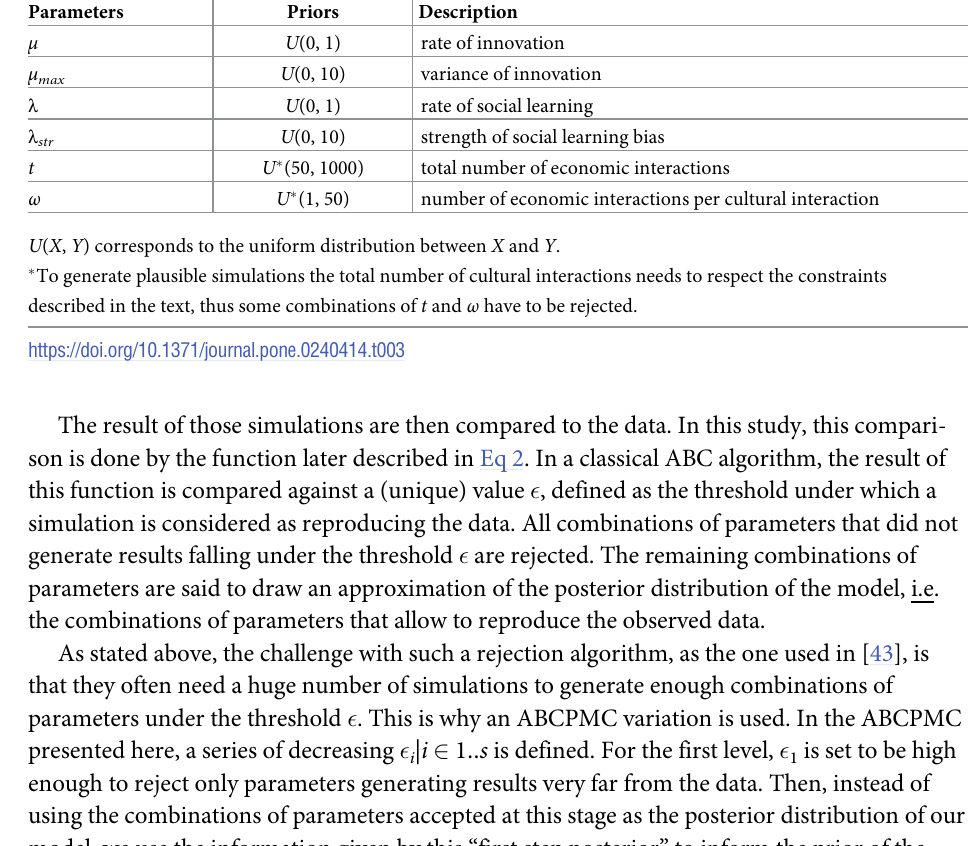
Table 3. Prior distributions for parameters to be inferred by the ABC. Parameters